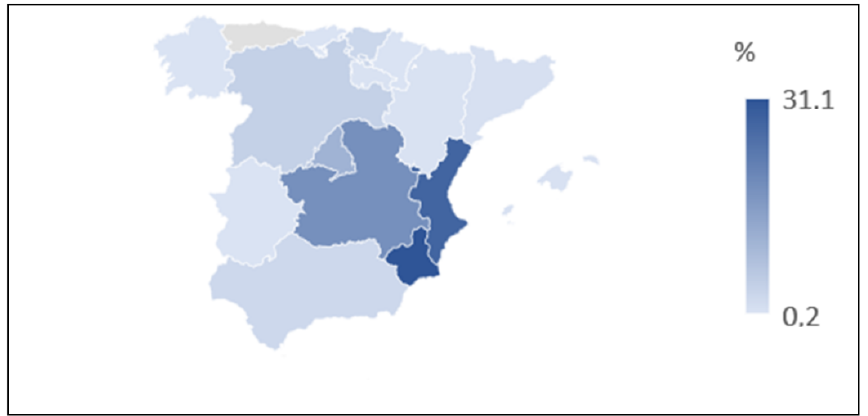
Figure 1. Sample distribution by autonomous community of origin.